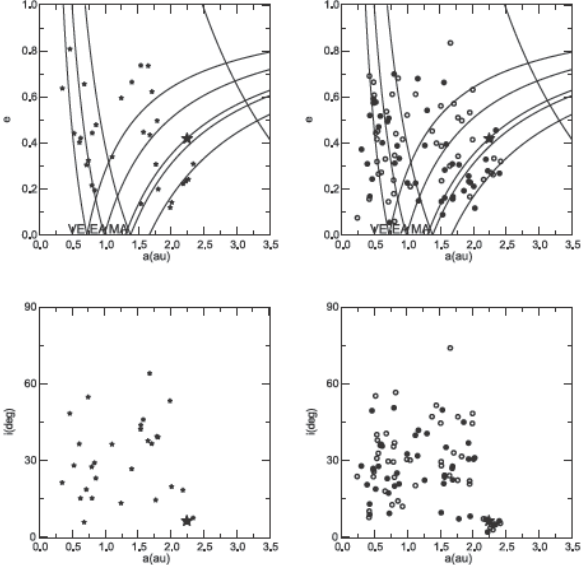
Figure 3. Remaining clones of 2008 LX16 after 100 My forward integration in the ( a , e ) plane - top panels and in the ( a , i ) plane - bottom panels. Small stars denote the position of clones with the use of the old error model based on Farnocchia et al. (2015) and with adding four massive bodies: (1) Ceres, (2) Pallas, (4) Vesta and (10) Hygiea (CPVH), dots - using the new error model based on Vereš et al. (2017) and with adding four massive bodies, CPVH, open circles denote positions of remaining clones computed without CPVH massive bodies and with the new error model. It is visible that almost all remaining clones in phase space have orbits with aphelia smaller than the semimajor axes of Mars and perihelia larger to the semimajor axis of Venus.